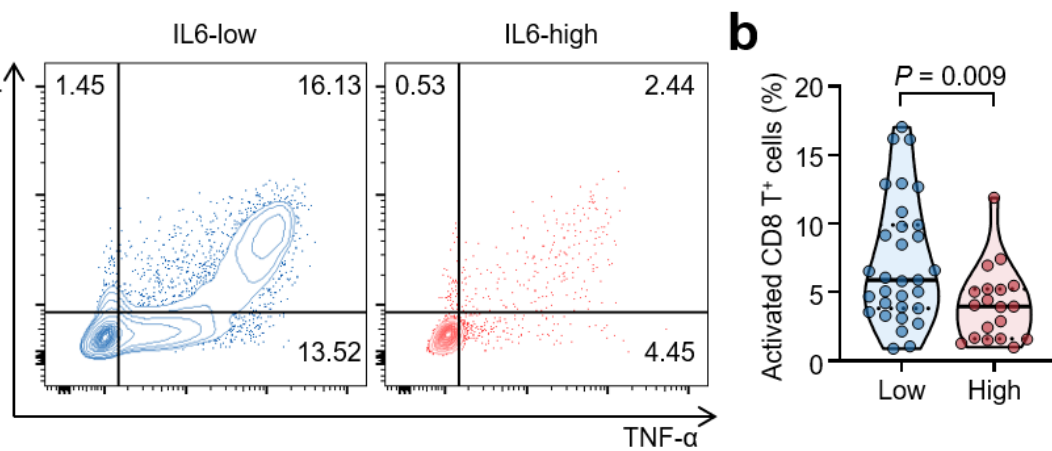
Figure 4. High serum IL-6 levels are associated with reduced CD8+ T cell function. ( a , b ) Representa- tive flow cytometric plots and comparison of intracellular interferon- γ (IFN- γ ) and tumor necrosis factor- α (TNF- α ) levels from CD8+ T cells according to IL-6 status. T cells were stimulated with an anti-CD3 antibody for 24 h. Values were compared using a t -test, with respective p -values given in the